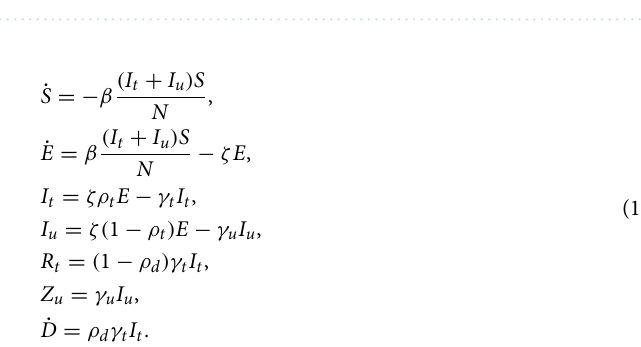
Figure 1. ( a ) Flow diagram for the compartment of model 1. Panels ( b–d ) show a typical time evolution of model variables. As the epidemic progresses, ( b ) the number of susceptible individuals decreases. The number of exposed individuals initially increases, reaches a peak and decreases at later stages of the epidemic. ( c ) The progression of the number of both tested and untested infected individuals also exhibits a peak. The decay of I t and I u after the peak induces a gradual weakening of the chain of transmission that leads to the end of the epidemic. ( d ) The number of tested and untested individuals that recover from infection or die increase monotonically during the